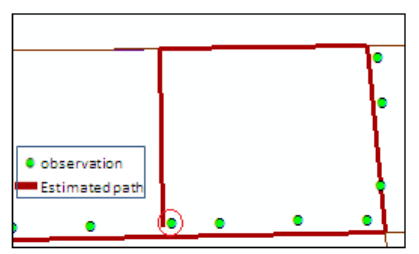
Figure 4. Weakness of point to curve method due to ignoring lack of connection in intersections  High density of network lines: in networks with lines of higher density, probability of error and incorrect positioning of arcs in the estimated path more seriously.